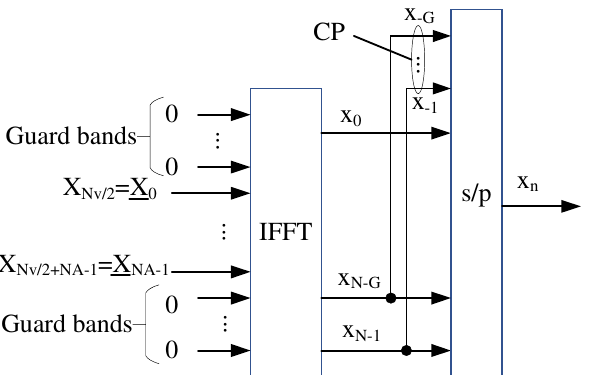
Figure 2. Block diagram of the Orthogonal Frequency Division Multiple (OFDM)